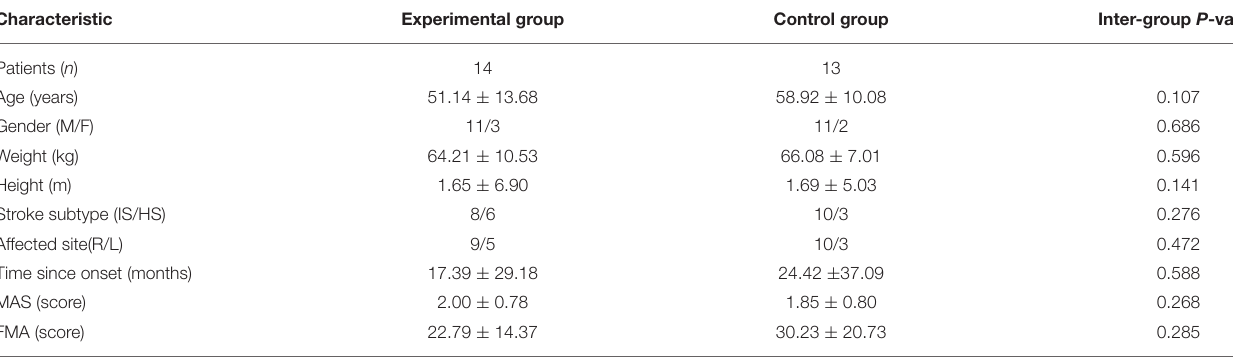
TABLE 1 | The characteristic of the sample